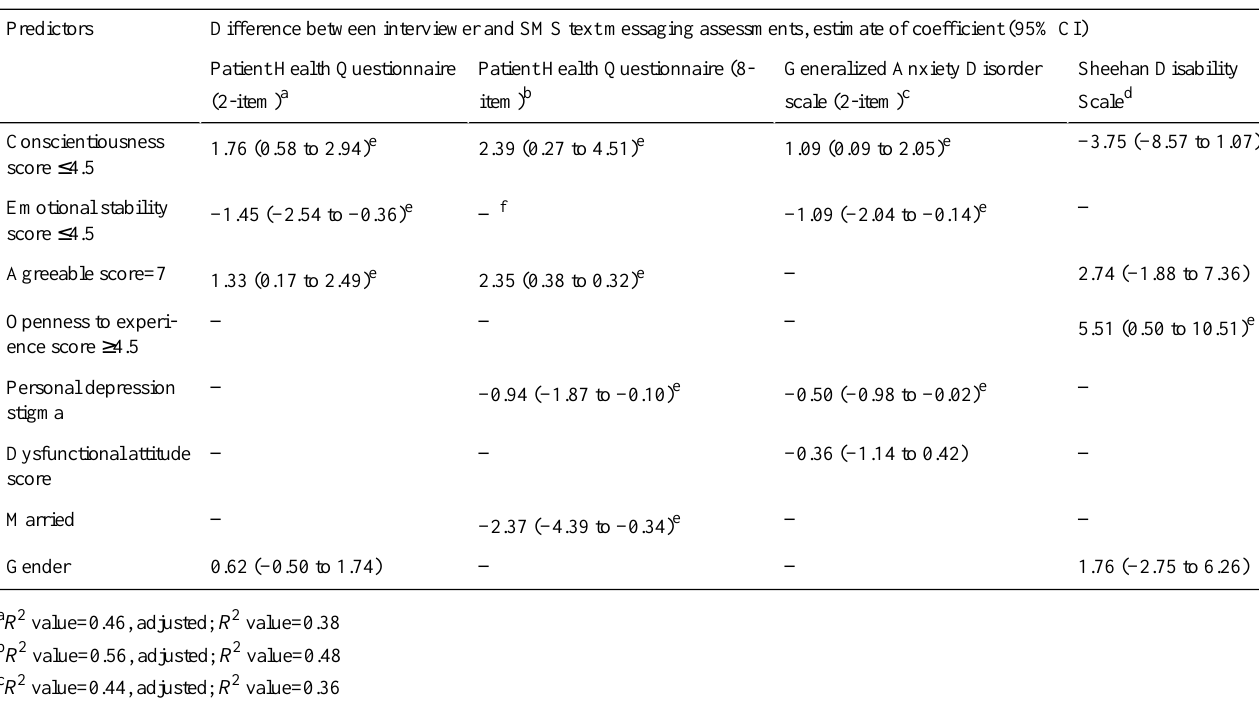
Table 4. Linear regression analysis using the top 4 predictors selected by least absolute shrinkage and selection operator to predict the differences between the interviewer and SMS text messaging